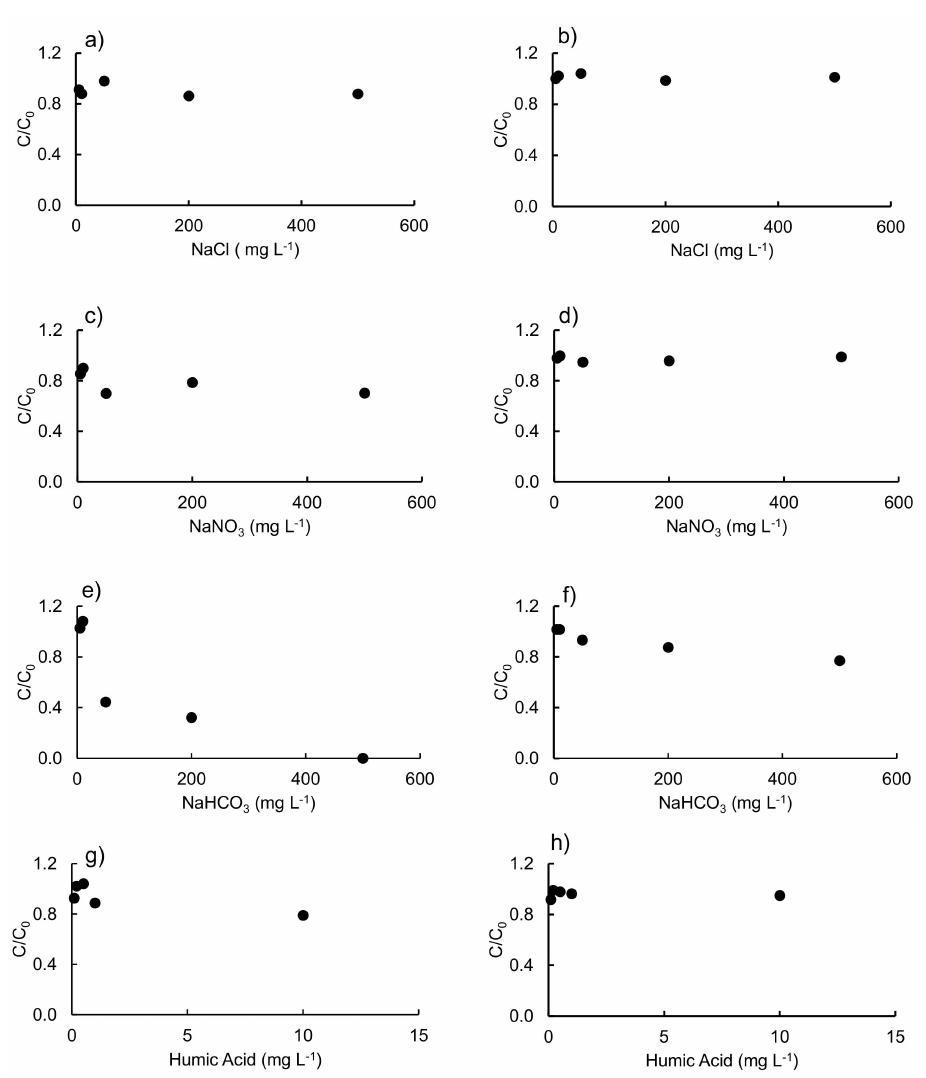
Figure 5. Doxycycline (DC) degradation under simulated sunlight and in the dark, in the presence of different salts or humic acids. ( a ) Presence of NaCl under simulated sunlight; ( b ) Presence of NaCl in the dark; ( c ) Presence of NaNO 3 under simulated sunlight; ( d ) Presence of NaNO 3 in the dark; ( e ) Presence of NaHCO 3 under simulated sunlight; ( f ) Presence of NaHCO 3 in the dark; ( g ) Presence of humic acids under simulated sunlight; ( h ) Presence of humic acids in the dark. Coefficients of variation were always lower than